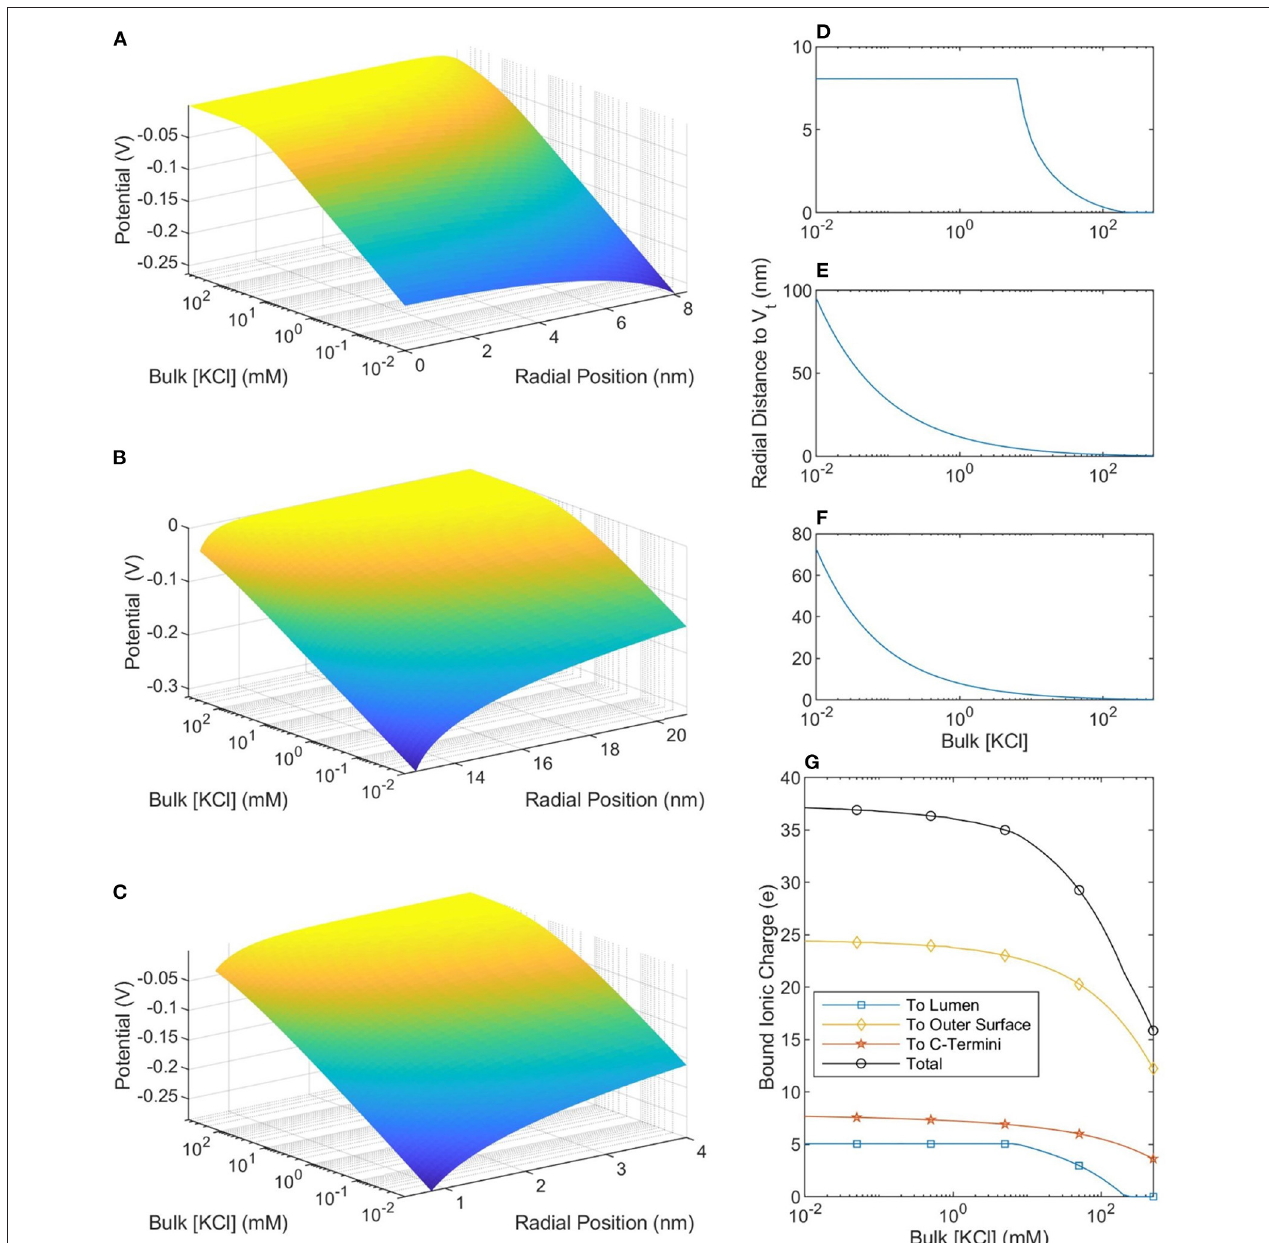
FIGURE 5 | The potential profiles—as a function of buffer ionic concentration—in the lumen (A) , around the outer SMT surface (B) , and around a CT (C) . The radial position in (A,B) is measured from the center of the SMT while the radial position in (C) is measured from the center of the CT. (D–F) Show, respectively, the distance from the lumen, outer SMT surface, and CT surface to the thermal voltage. The maximum value in (D) is the radius of the lumen and at these points the entire lumen has a potential greater than the thermal potential. (G) Shows the total ionic charge within the thermal voltage potential, which can be considered the charge “bound” to the